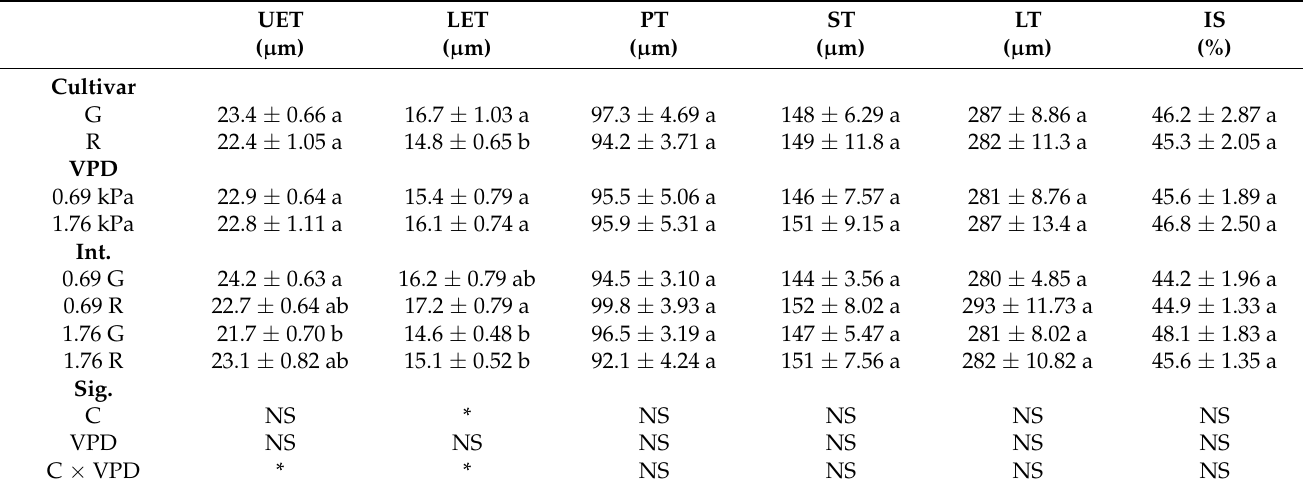
Table 2. Morpho-anatomical analyses consisting of upper epidermis thickness (UET), lower epidermis thickness (LET), palisade thickness (PT), spongy thickness (ST), lamina thickness (LT) and percentage of intercellular spaces (IS) in green (G) and red (R) lettuce plants grown under the two VPD levels (0.69 and 1.76